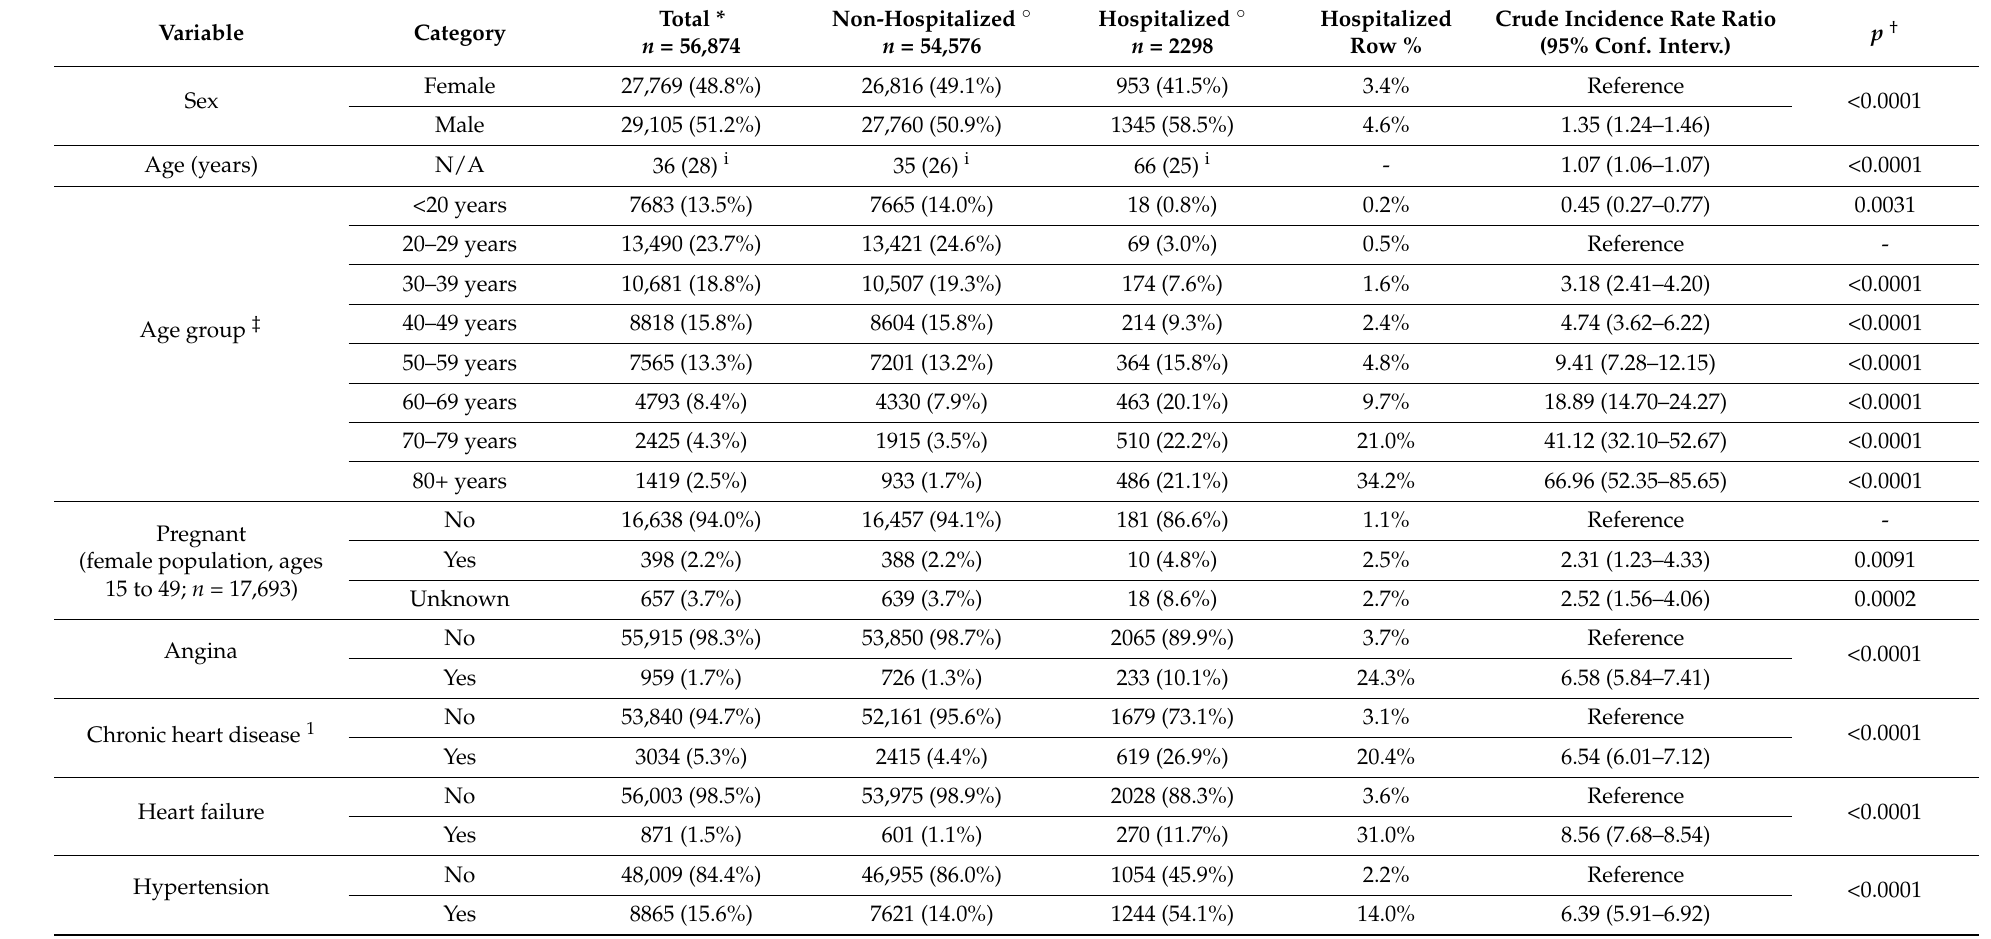
Table 1. Distribution of characteristics in the BC COVID-19 cohort (confirmed cases, n = 56,874), according to hospitalization